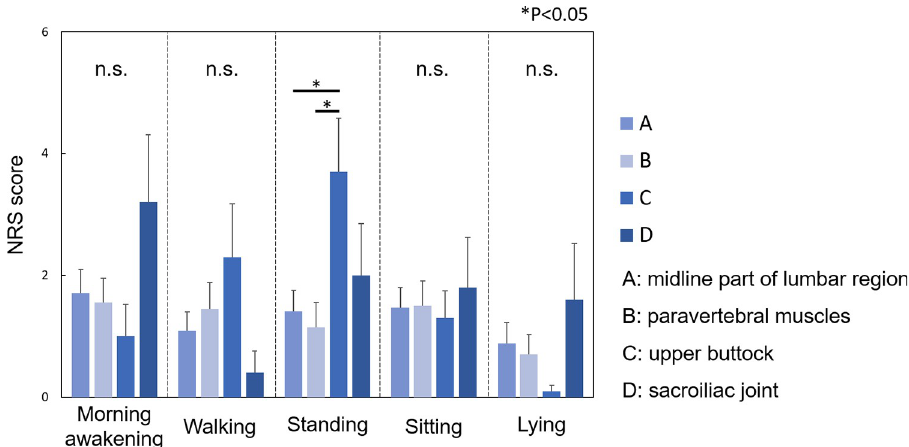
of LBP in morning awakening, walking, sitting, and lying.